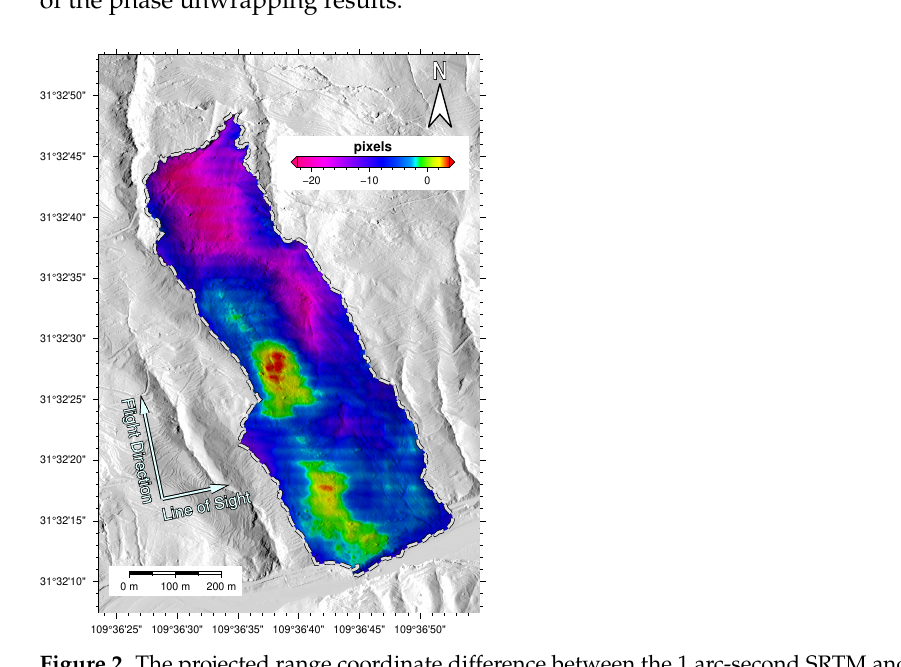
Figure 2. The projected range coordinate difference between the 1 arc-second SRTM and the LiDAR look-up tables.